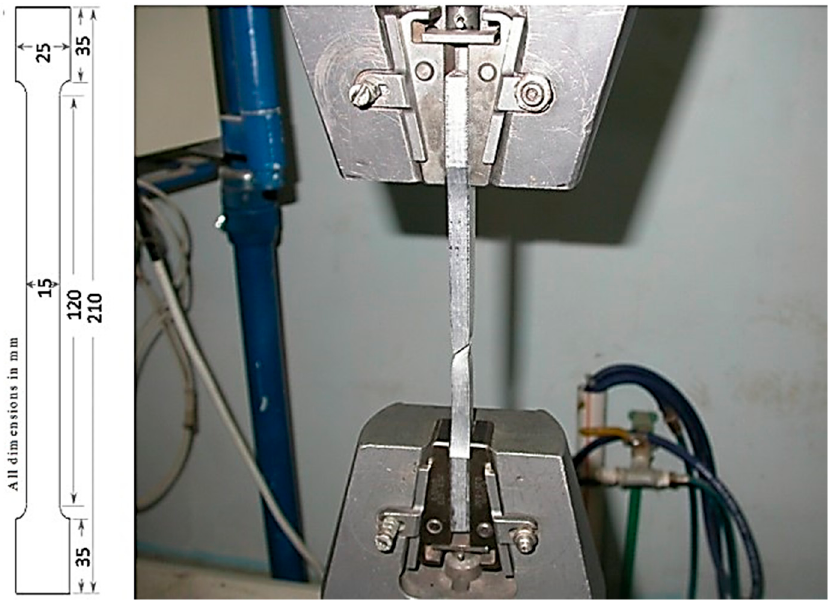
Figure 3. The dimensions of the tensile specimen and an image of the sample after tensile testing.